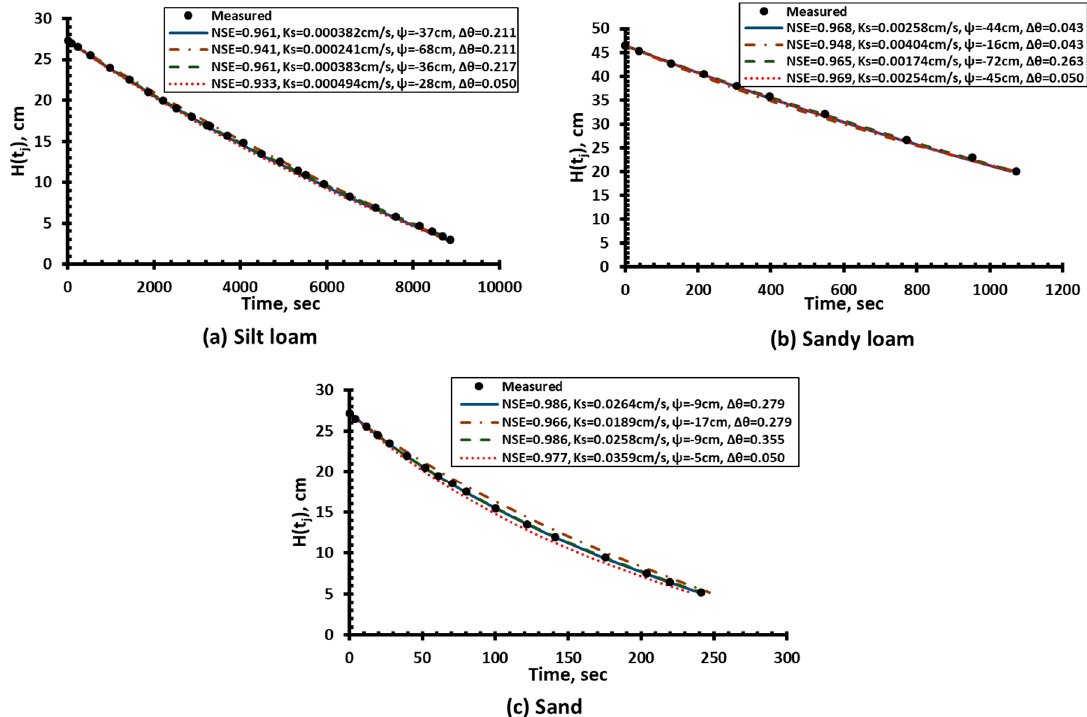
Figure 5. The field-measured and the simulated drawdown curves using the sets of parameters with the highest and threshold NSE values (determined using ∆ t ) and for K s and Ψ back-fitted using two assumed ∆ θ values: ( a ) silt loam, ( b ) sandy loam, and ( c ) sand. Note, the dots show measured drawdown data, the blue lines give the drawdown curves with the highest NSE (e.g., 0.961 for silt loam), and brown dash-dotted lines give the drawdown curves with the selected NSE threshold (e.g., 0.941 = 0.98 × 0.961 for silt loam).